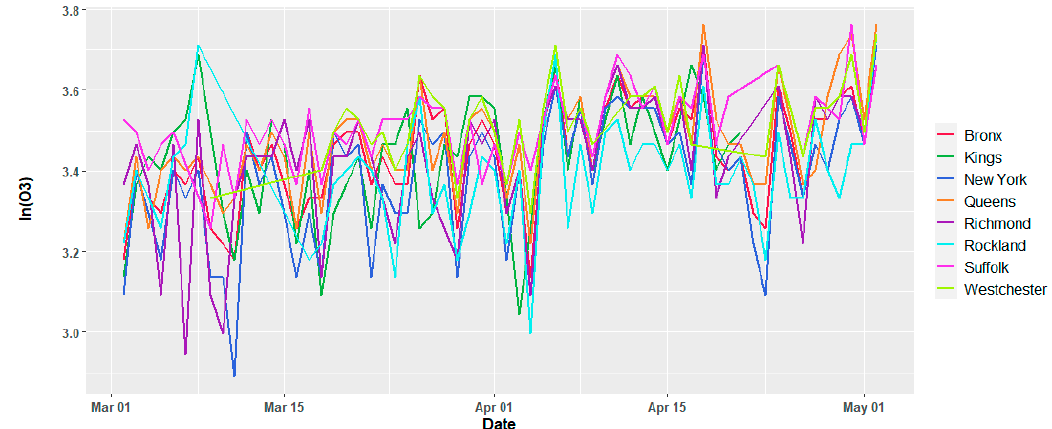
Figure 5. Variation of the daily average concentration of ozone (in mg/ m 3 ) in natural logarithmic scale for individual counties.